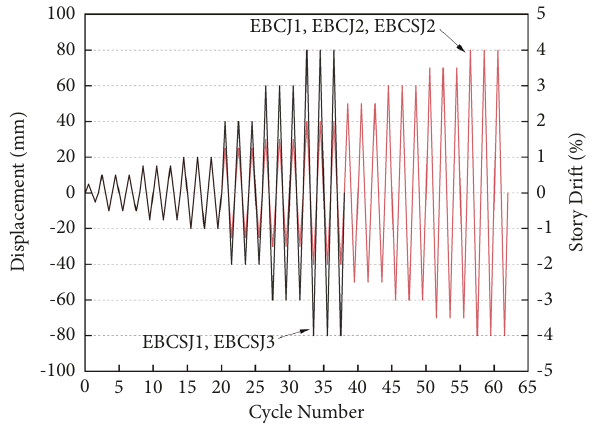
Figure 4: Cyclic loading